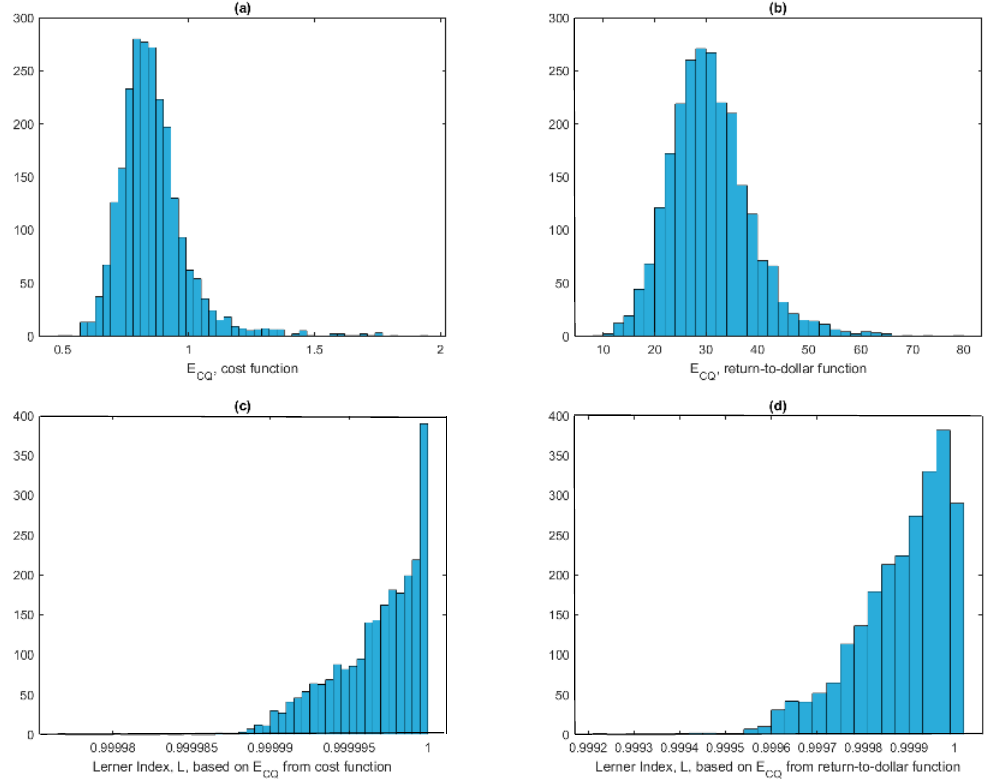
Figure 1. Estimates of E CQ and Lerner index an in KL.